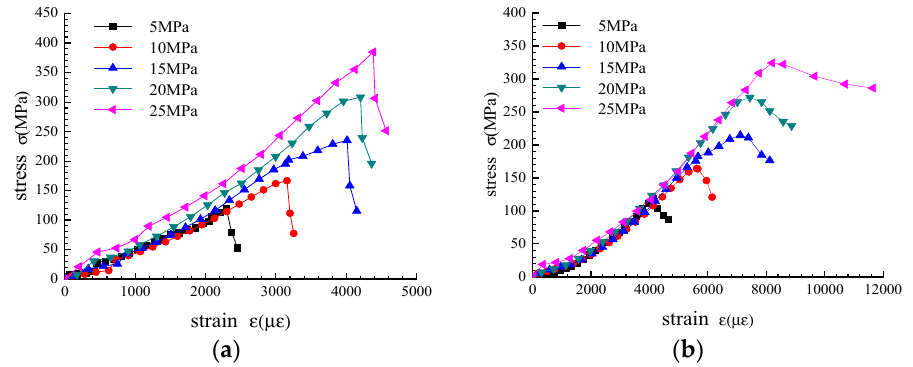
Figure 8. Stress–strain curves under different confining pressures. ( a ) Gneiss in high geostress areas. ( b ) Gneiss in conventional geostress areas.